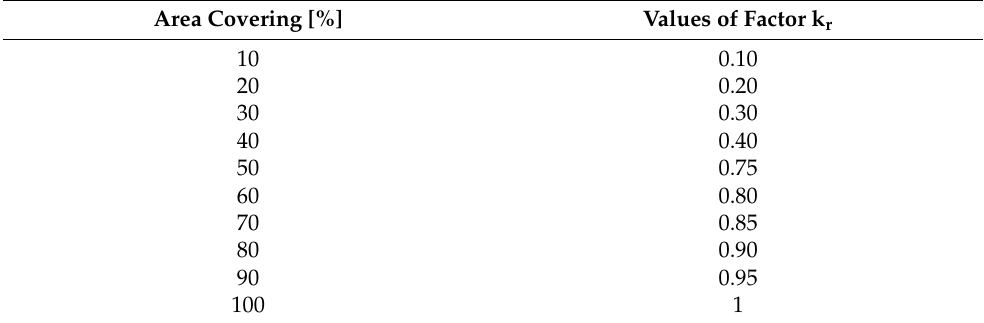
Table 1. Values of the correction factor k r according to Freeman and